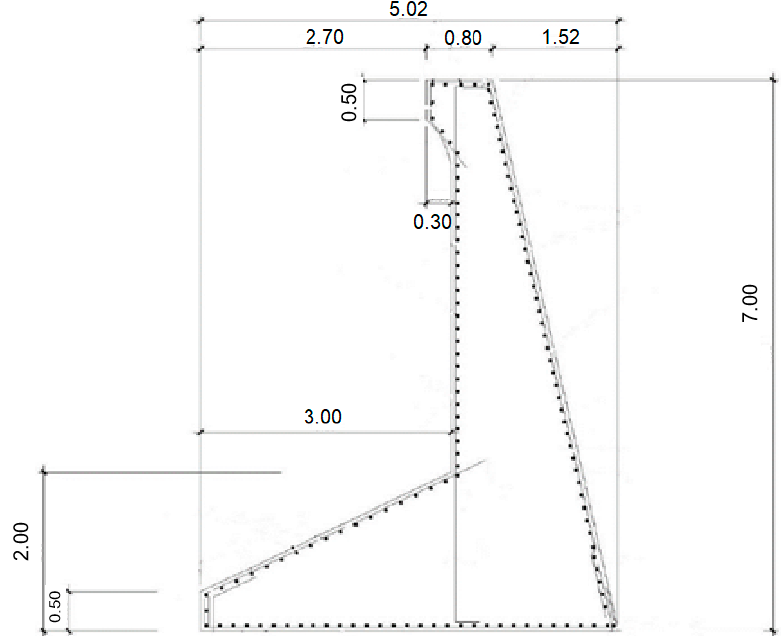
Figure 3. General drawing.